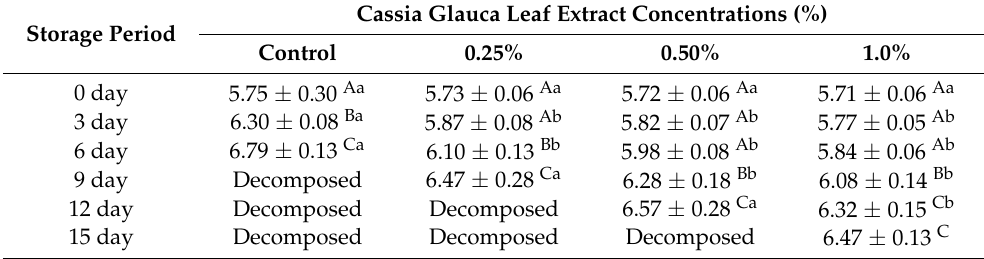
Table 2. The pattern of the pH values of minced beef treated with ethanolic Cassia glauca leaf extracts (0.25%, 0.5%, 1%) during the cold storage period at 3 ± 1 ◦ C (mean ± standard deviation “SD”).